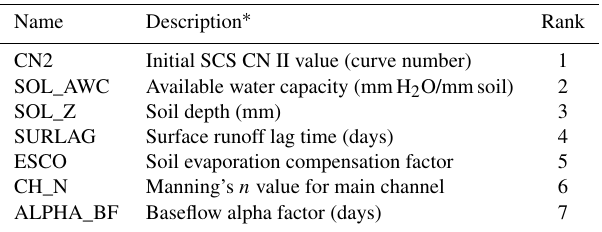
Table 3. Results of parameters sensitivity analysis of scenario